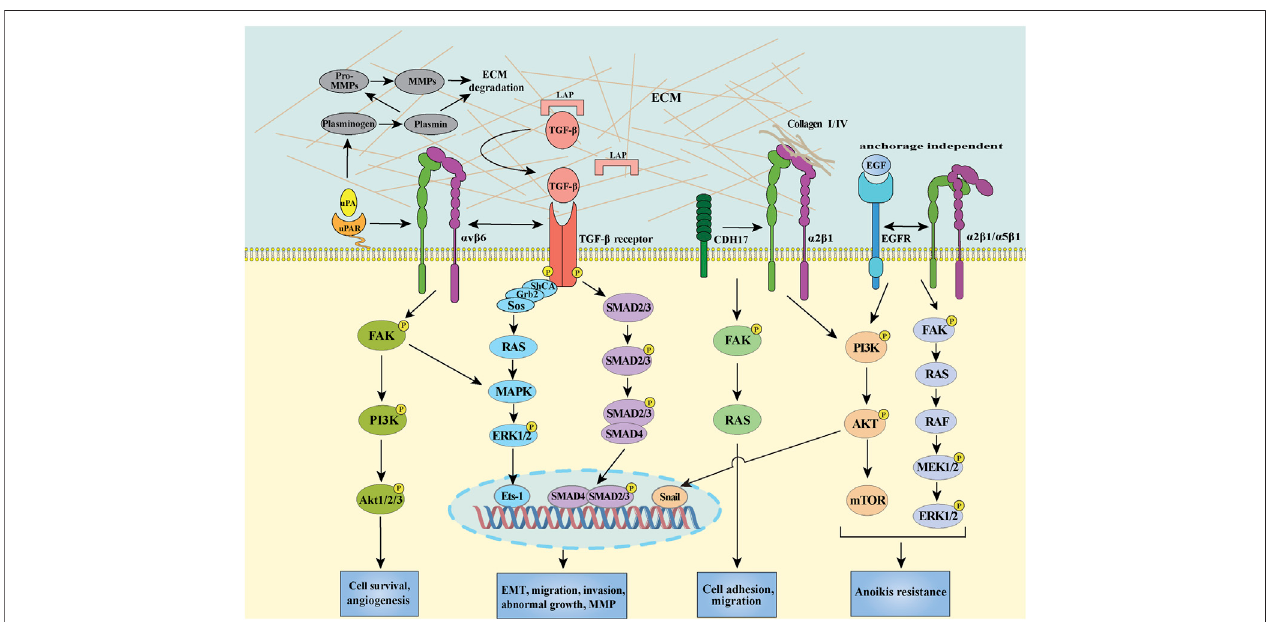
FIGURE 2 | Schema of integrin α v β 6/TGF- β receptor/uPAR, integrin α 2 β 1/CDH17, integrin α 2 β 1 (or α 5 β 1)/EGFR mediated signal transduction pathways in CRC. Integrin α v β 6 separately interacts with uPAR and TGF- β receptor, initiating intracellular signaling contributes to the activation of transcription factors, such as Ets-1 and SMAD2/3/4 throughtheFAK/PI3K, RAS/ERK,and SMADpathways. CDH17provokesaconformationalchangeinthe β 1subunit, activating thedownstream FAK/RAS pathway to increase cell adhesion. The crosstalk between integrin α 2 β 1/ α 5 β 1 and EGFR can induce PI3K/AKT signaling to promote EMT through stimulating transcriptionfactorsnailinCRCcells.Ontheotherhand,integrin α 2 β 1/EGFRalsocanactivateFAK/ERKandPI3K/AKTsurvivalpathwayresultinginanoikisresistancein the absence of